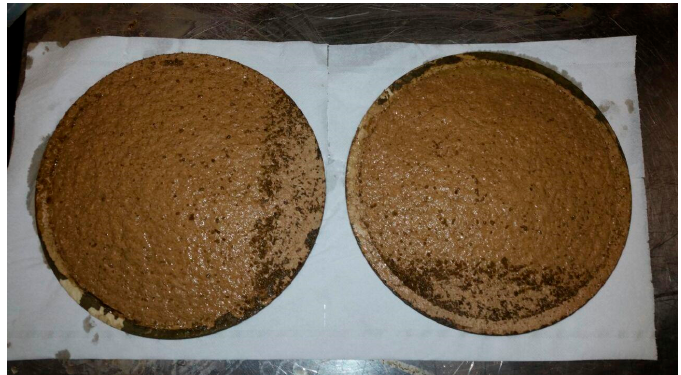
Figure 7. Filters BECOPAD 550.